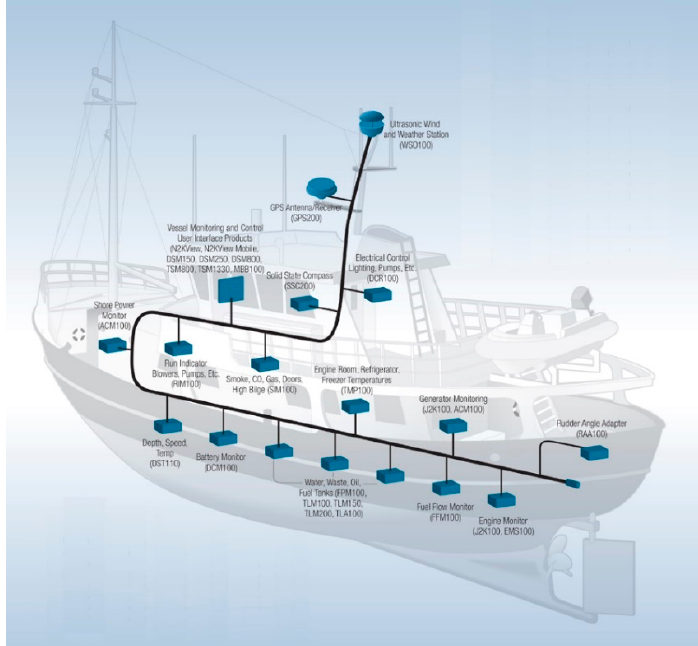
Figure 2. NMEA 2000 network vessel distribution [71].